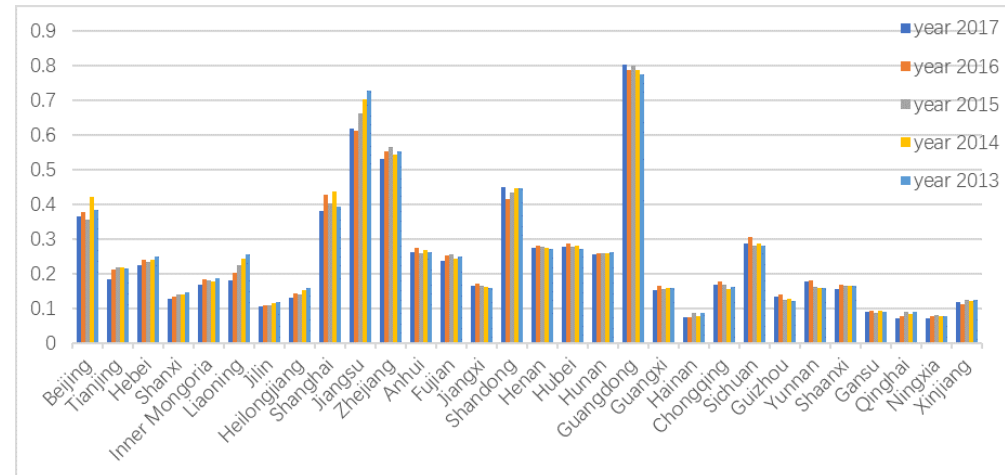
Figure 3. Comparison of the RLGIL comprehensive evaluation